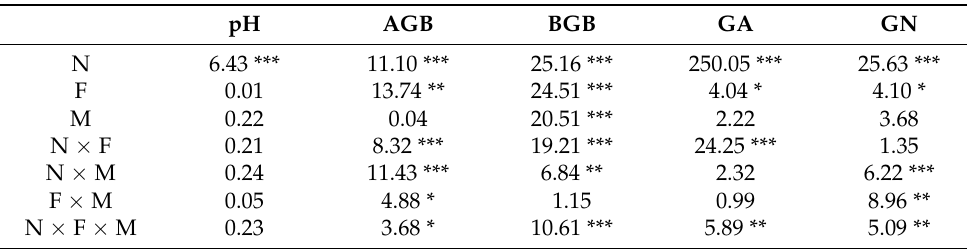
Table 1. Results (F values) of repeated measures ANOVAs testing the effects of N addition rate (N), N addition frequency (F), and mowing (M) on soil pH, AGB, BGB, gross ammonification rates (GA), and gross nitrification rates